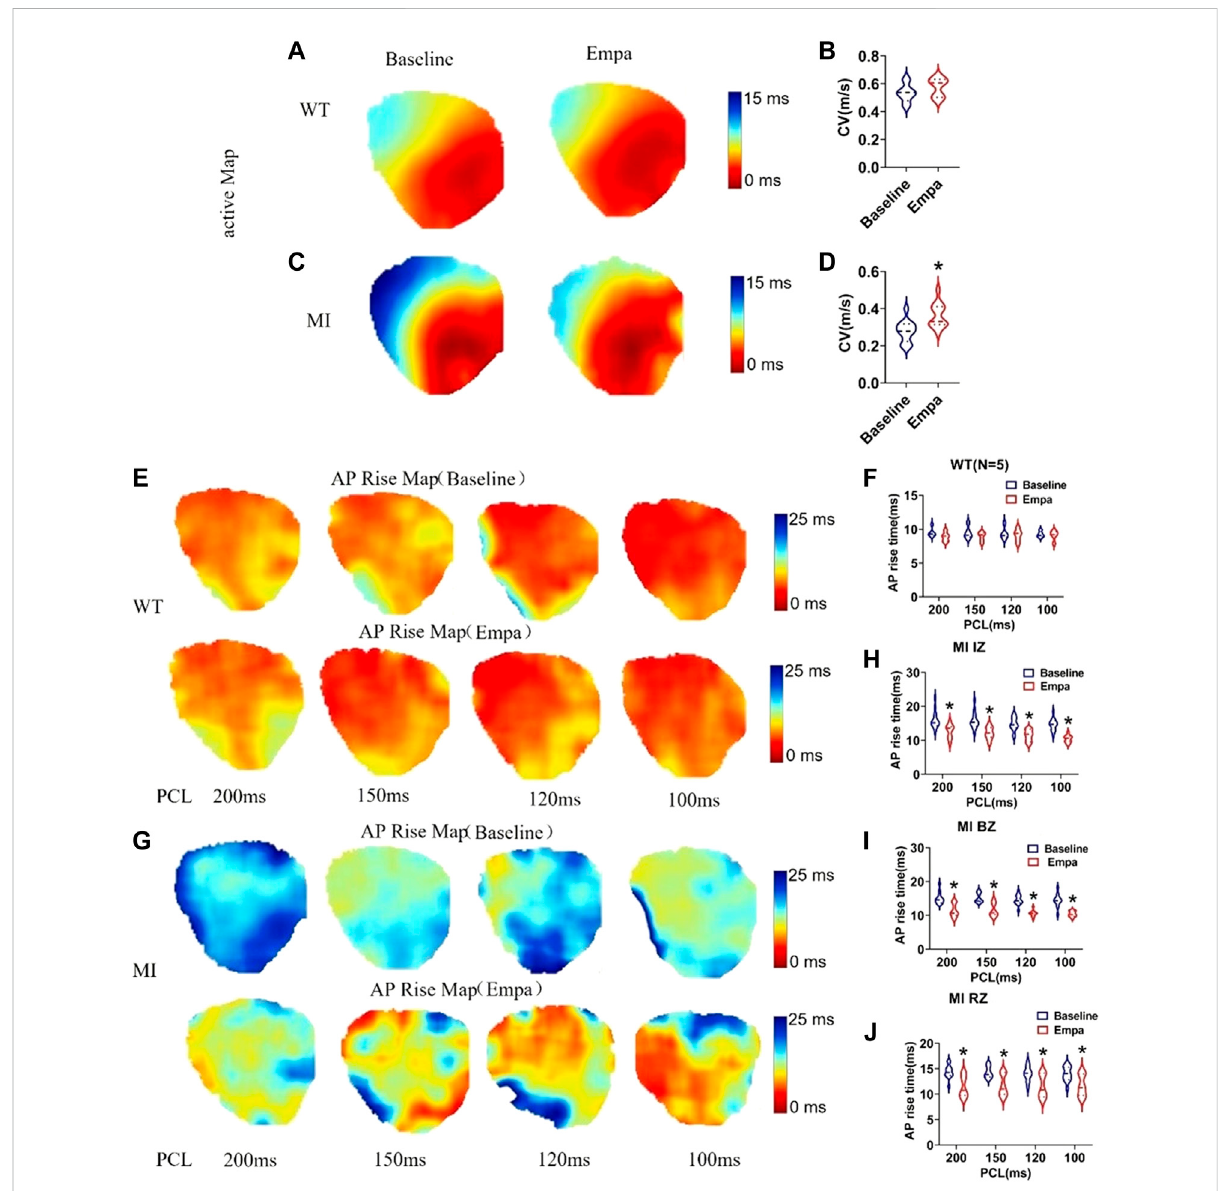
FIGURE 3 Effects of EMPA on conduction velocity (CV) and AP rise time at different pacing cycle lengths (PCLs) in normal and infarcted ventricles. (A,C) Maps of activation at baseline and in the presence of EMPA (10 umol/L) in normal and infarcted ventricles. (B,D) conduction velocity at baseline and after EMPA infusion in normal and infarcted ventricles. N = 5 for WT; N = 13 for MI. * p < 0.05 versus baseline. p -values were determined using the unpaired t test. (E) Action potential (AP) rise time (TRise) mapsassociated with different PCLsat baseline and inthepresence ofEMPA (10 umol/ L) in normal ventricles. (F) TRise associated with different PCLs at baseline and after EMPA infusion in normal ventricles. N = 5 . (G) TRise maps associated with different PCLs at baseline and in the presence of EMPA in infarcted ventricles. (H – J) TRise associated with different PCLs at baseline and after EMPA infusion in infarcted ventricles of IZ, BZ, and RZ. N = 11 – 13 . * p < 0.05 versus baseline. p -values were determined using the unpaired t